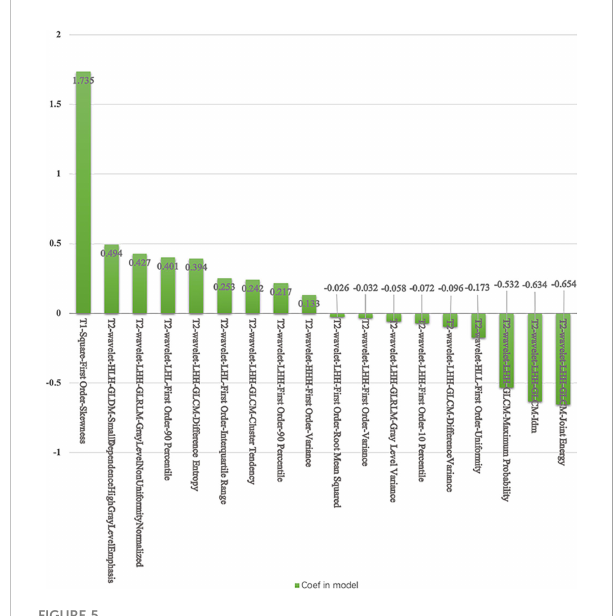
FIGURE 5 The selected features and coef fi cients in the